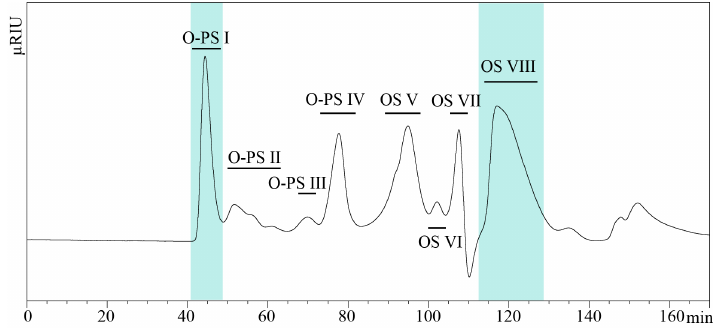
Figure 2. Separation of the O-PS and OS components of B. holmesii ATCC 51541 LPS hydrolyzate by gel-filtration chromatography on the Superdex 30 pg, with RI detector.